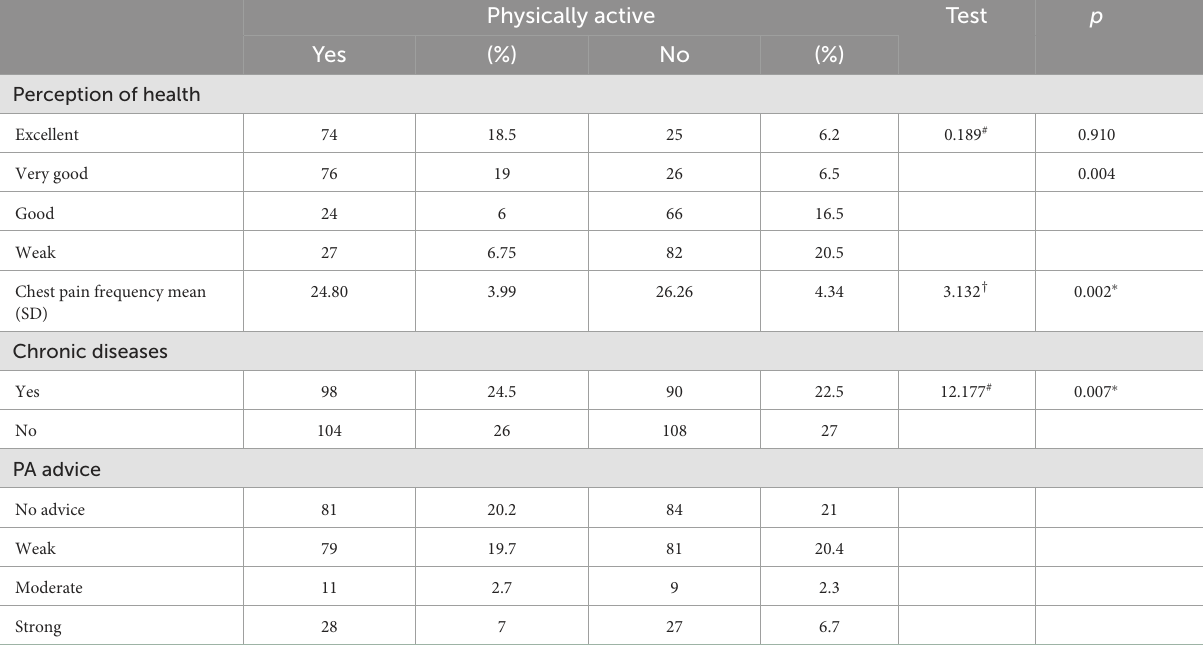
TABLE 4 Association between participants’ health characteristics and physical